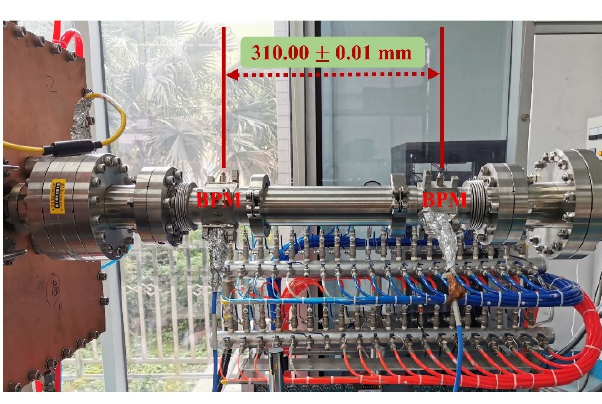
Appl. Sci. 2022 , 12 , 4013 Figure 17. The measured distance of the two BPMs. Figure 17. The measured distance of the two BPMs.